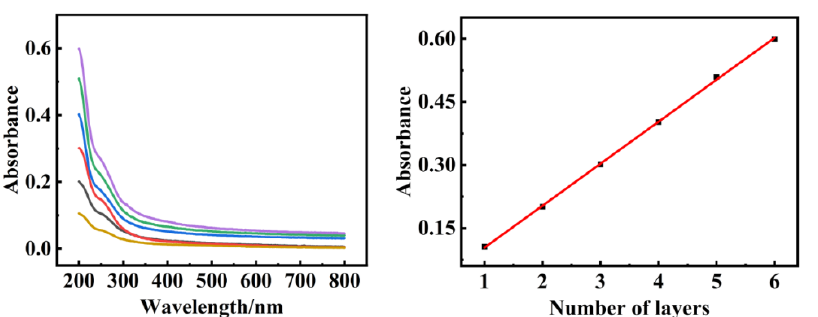
Figure 4. ( left ) UV − vis absorption spectra of the films [PDDA/Ni25] n recorded on the quartz slide with the layer numbers increasing from 1 to 6. ( right ) The relationship between the absorbance and the layer numbers at 200 nm.